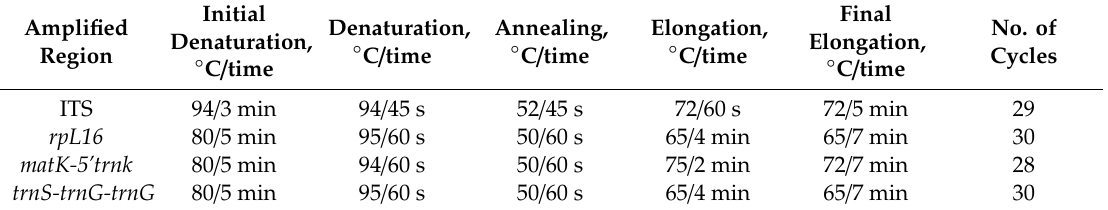
Table 4. Polymerase chain reaction (PCR) conditions for amplified